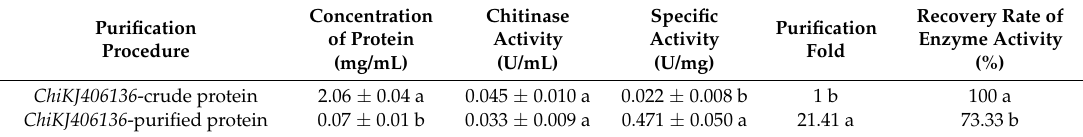
Table 1. Quantitative comparison between crude recombinant protein and purified recombinant protein a